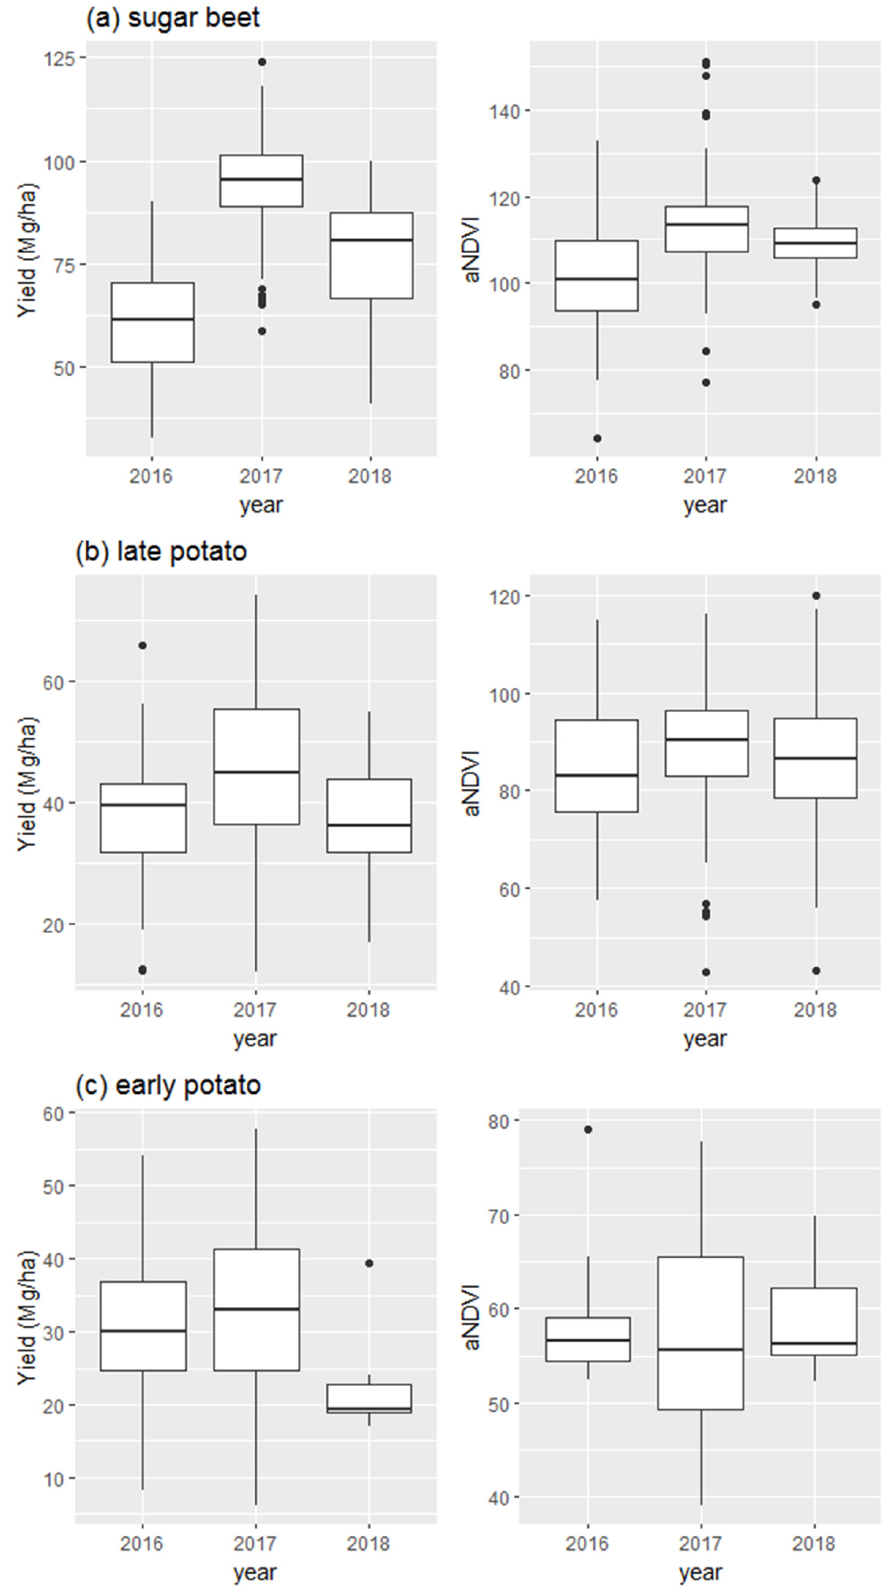
Figure 3. Boxplots of yield (Mg/ha, left graph) and aNDVI (right graph) for ( a ) sugar-beet fields (468 fields), ( b ) late-potato fields (685 fields), and ( c ) early-potato fields (38 fields) during 2016–2018.